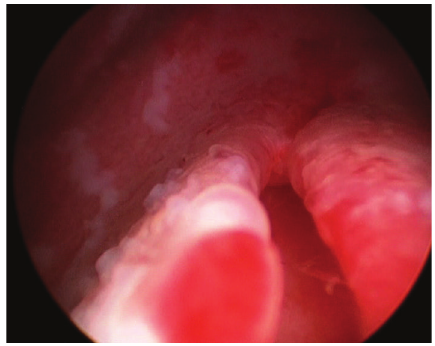
Figure 1: Intraoperative cystoscopy picture showing a fold on the posterior wall of the bladder neck.